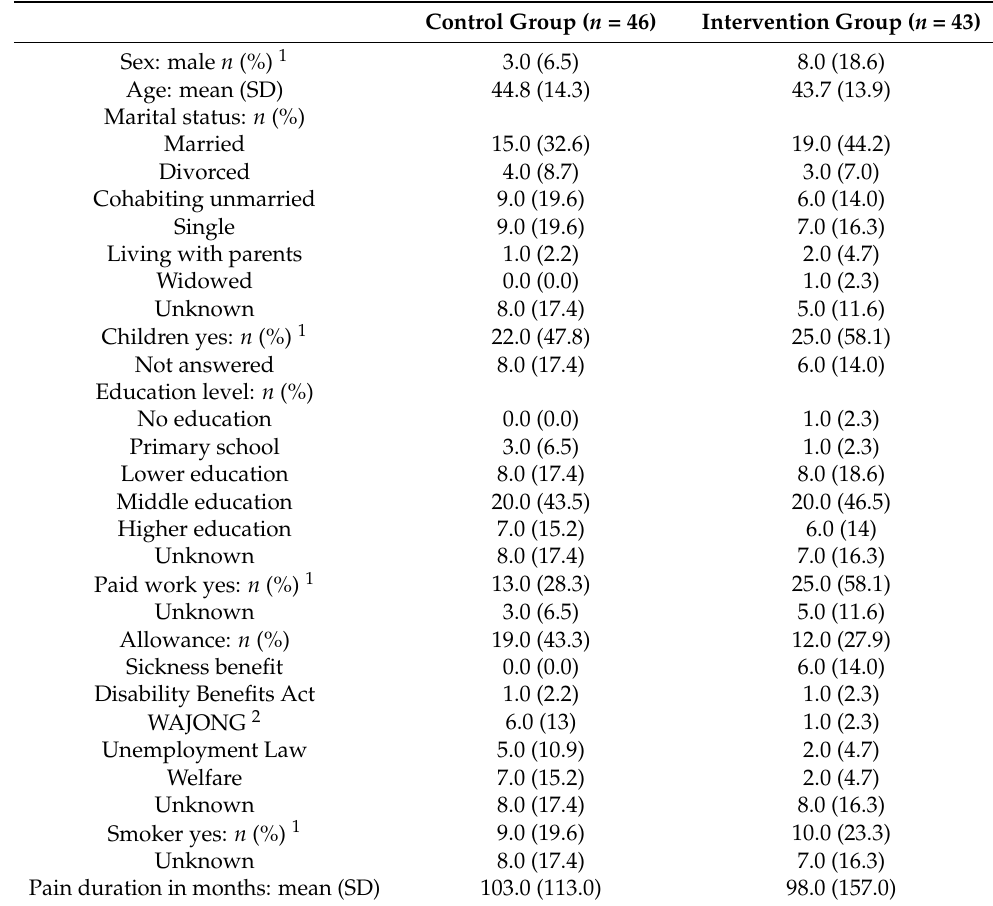
Table 1. Demographic data of both